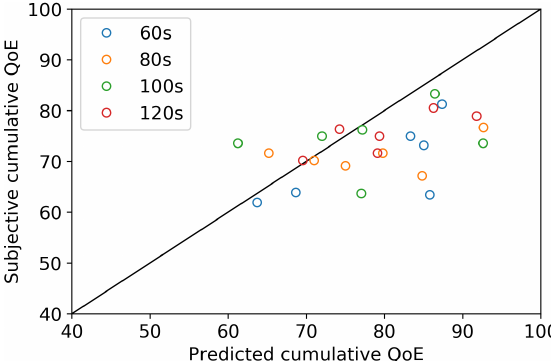
Figure 10. Scatter plot of predicted cumulative QoE and subjective cumulative QoE.